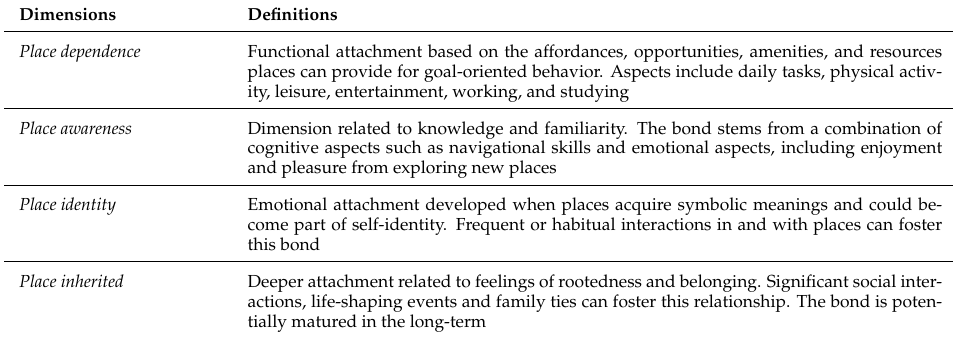
Table 1: The four dimensions of sense of place analyzed in this